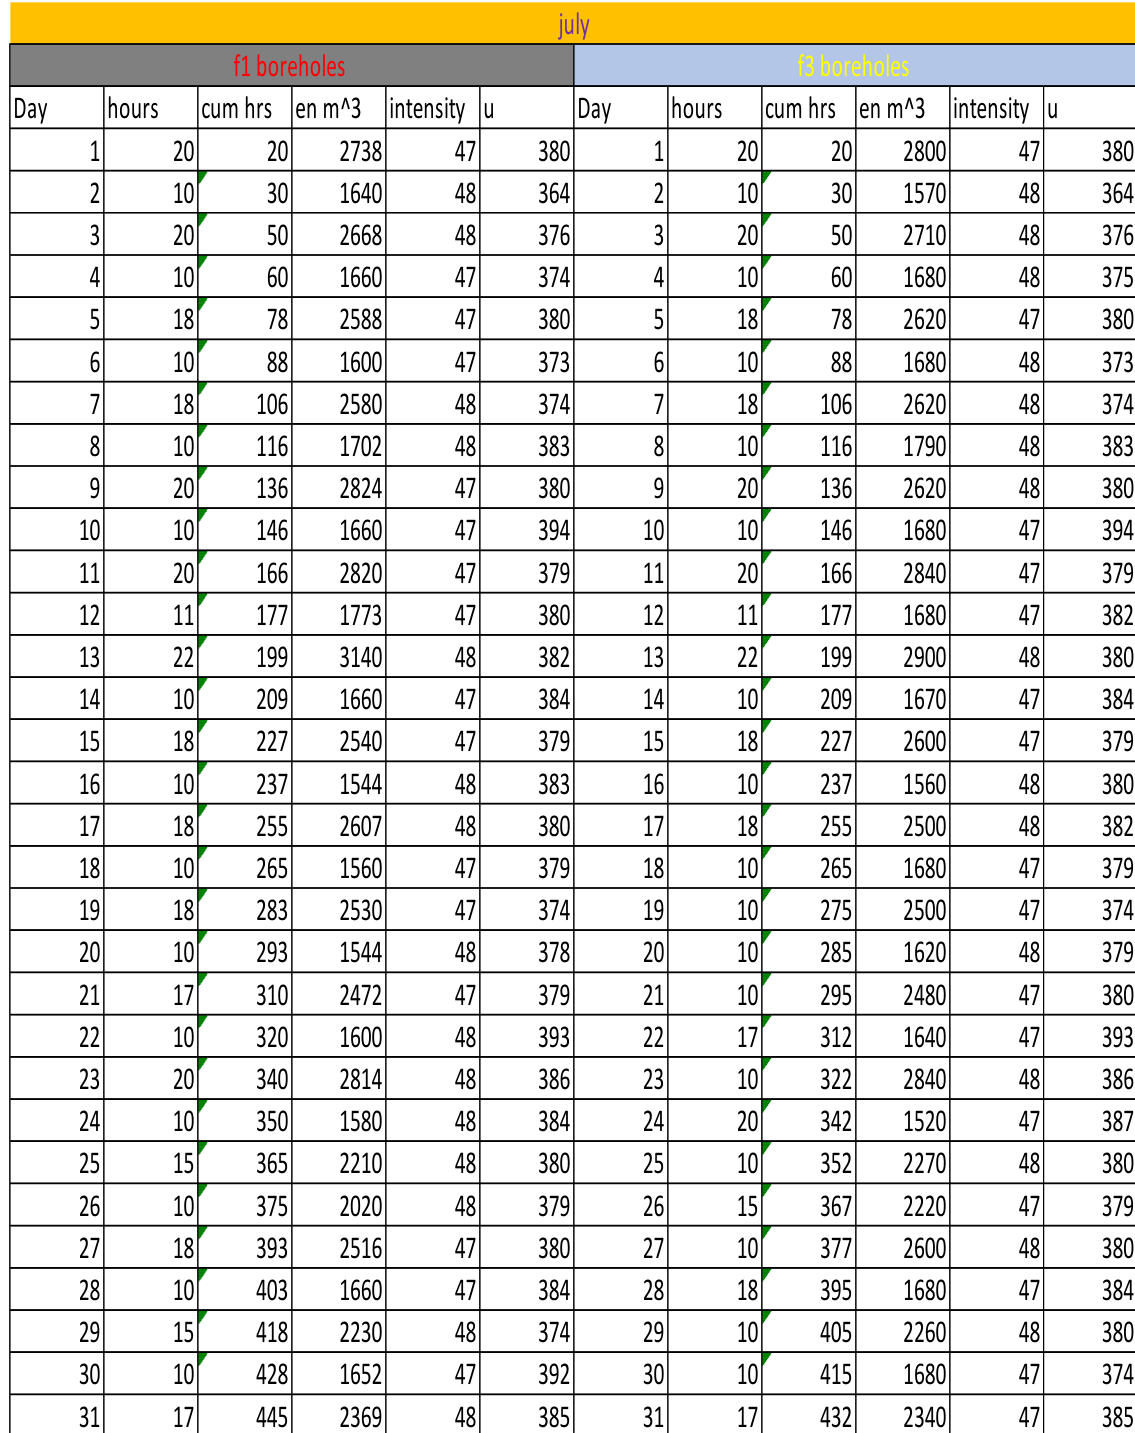
Figure A1. Daily yield on Kimbanseke for July.